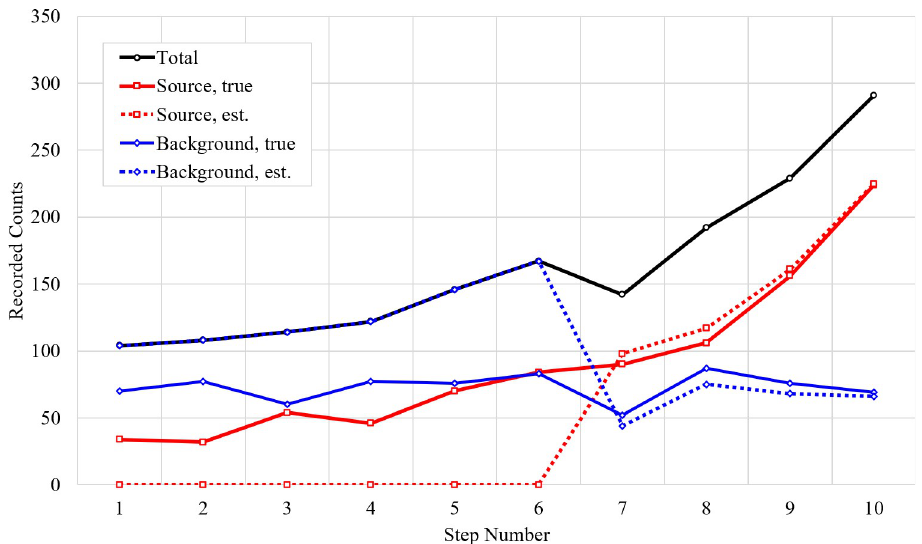
Fig 5. Example of count prediction. Representation of the counts and their quality as seen by the MLE-Bayesian approach with trained CNN. An anomaly is detected after the 6 th collection, leading to a good estimated separation of source and background counts. Background counts are shown in blue with diamonds–true is solid while estimated is dashed. Source counts are shown in red with squares–true is solid while estimated is dashed. Total counts is in black with circles.